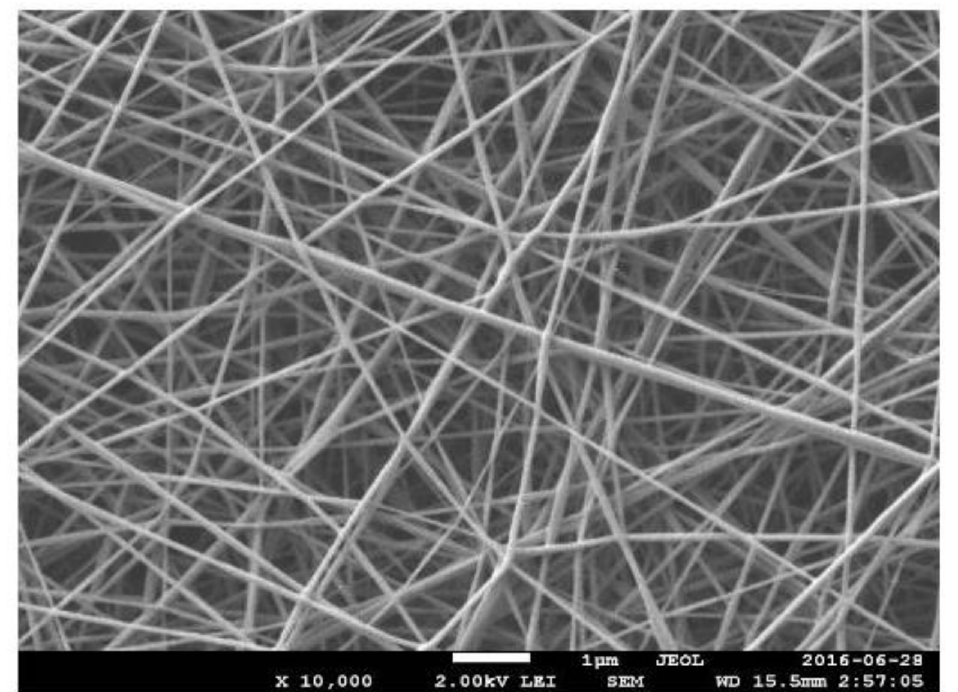
Figure 5. SEM micrograph of the PMMA/PANi nanofibers